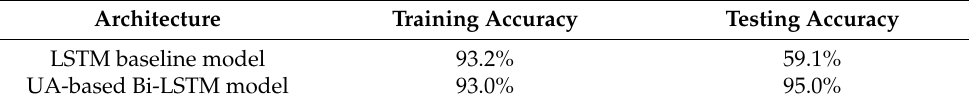
Table 7. Accuracy metrics by implementing a feature-based database as inputs in LSTM.